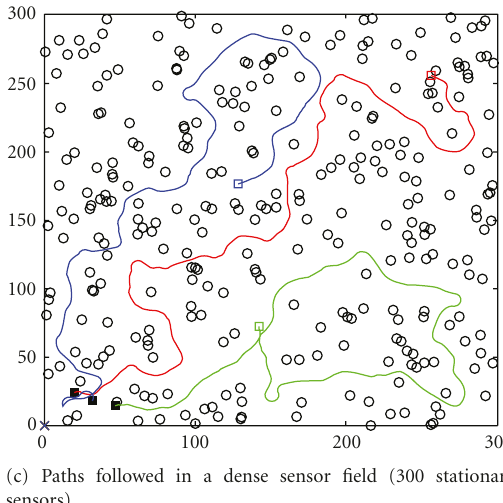
Figure 7: Paths followed after 300 moving steps by a set of three mobile sensor nodes using the distributed path planning algorithm for di ff erent sensor field